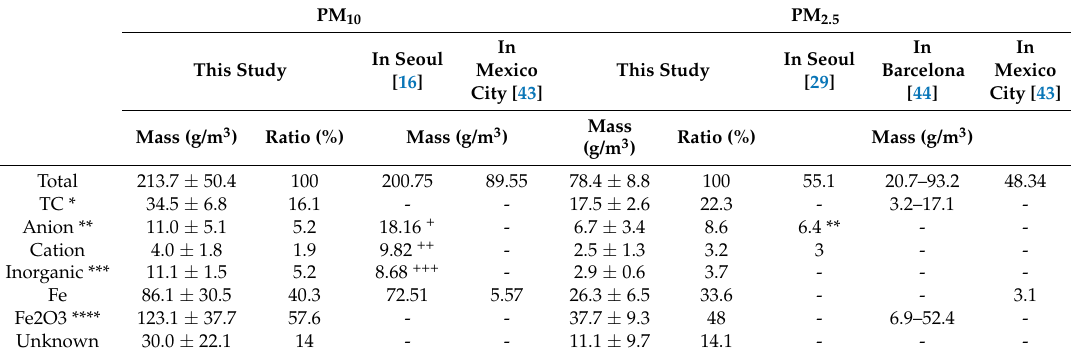
Figure 7. Mass concentrations of the carbonaceous components of PM in the subway tunnel at the M station ( n = 13). OC—organic carbon; CC—carbonate carbon; EC—elemental carbon. Table 3. Physical and chemical characteristics of PM at the M station ( n = 13).